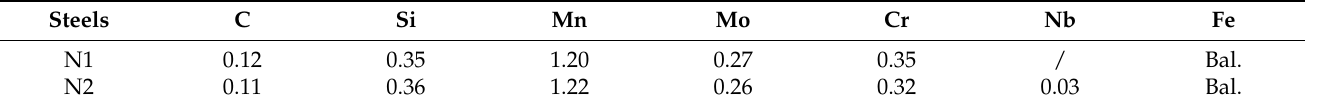
Table 1. Chemical composition of steels